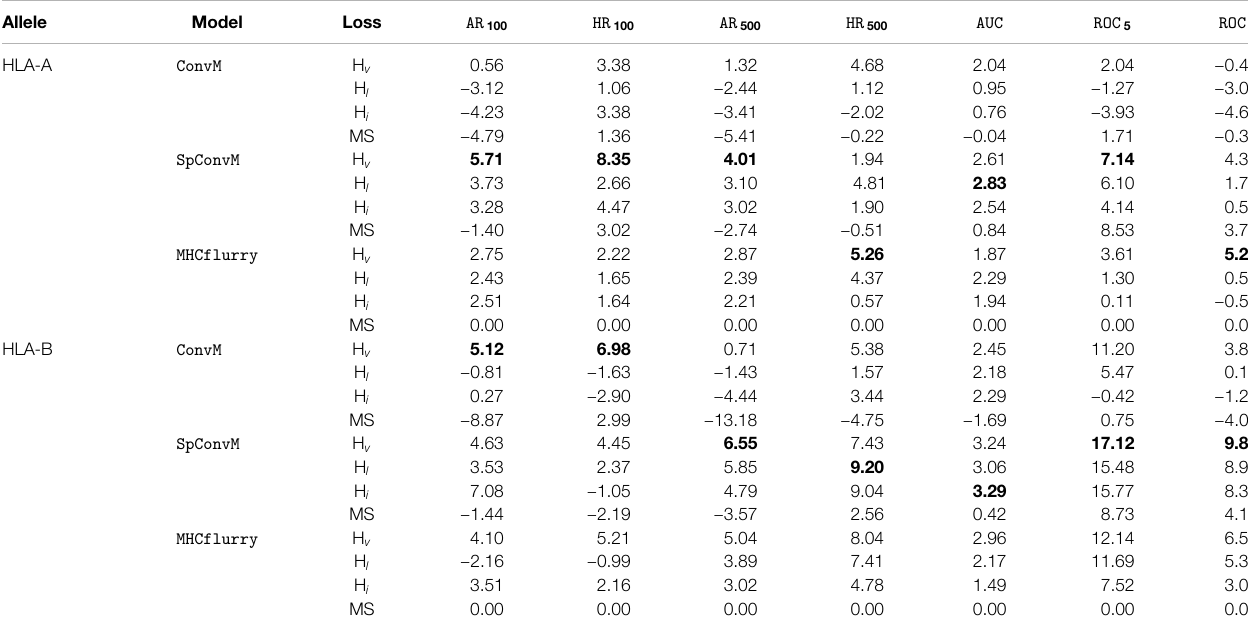
TABLE 5 | Overall performance comparison across HLA-A and HLA-B alleles ( H ; BLOSUM + Onehot + Deep ). Allele